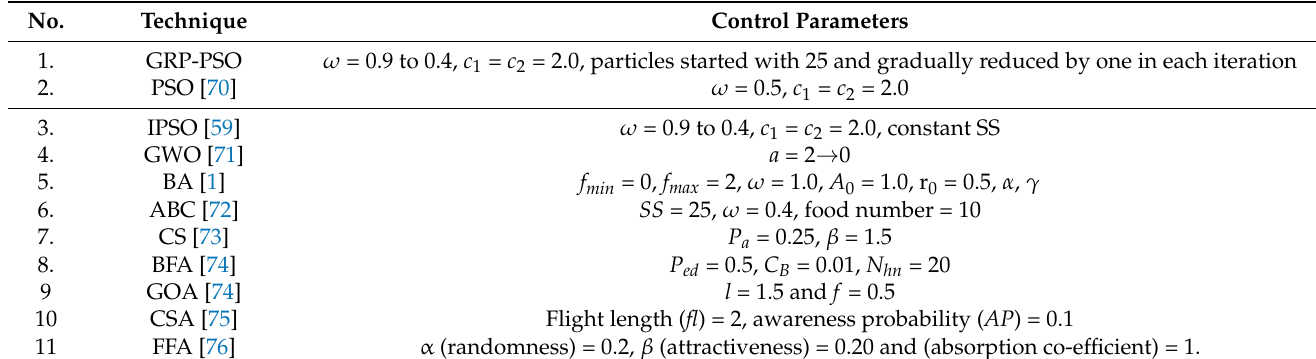
Table 3. The control parameters of the benchmark optimization algorithms used in this study.